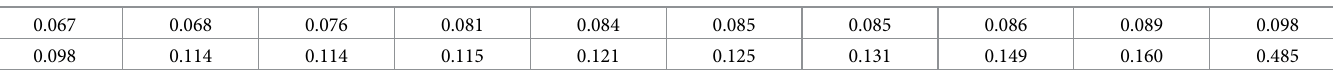
Table 1. Data set of failure times of 20 mechanical components.